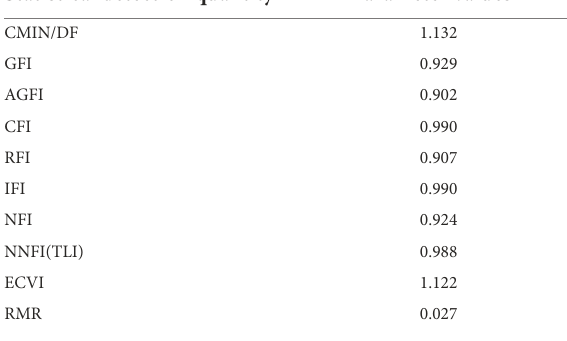
TABLE 3 Mediation model fit.